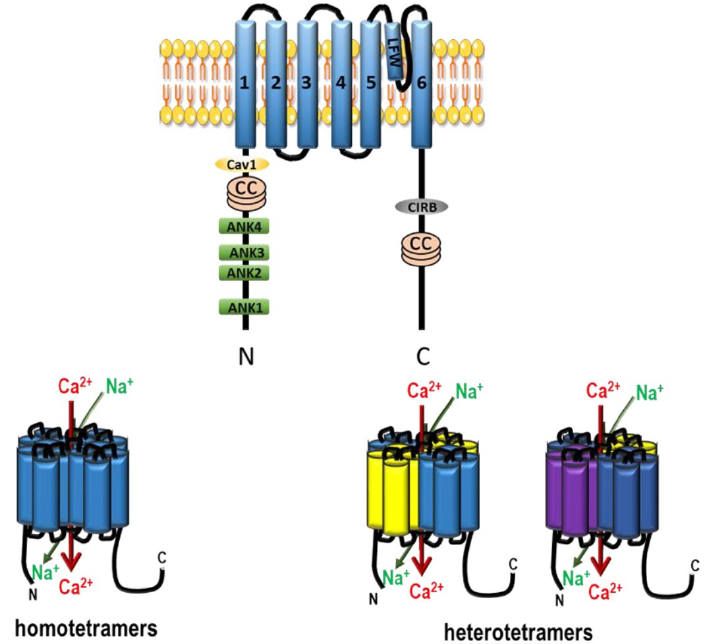
Figure 9. Architecture of TRPC channels. Each TRPC isoform is constituted of six transmembrane-spanning ion channels. Each TRPC subunit contains six transmembrane domains with the pore region (LFW, pore motif) between 5 and 6. Structural domains for channel assembly and protein interaction sites are located in the intracellular N and C termini. ANK1-4, ankyrin-like repeats; CC, coiled-coil domain; Ca v 1, caveolin-1 binding domain; CIRB, calmodulin–IP3R binding site. TRPC channels need homotetramerization or heterotetramerization to form a functional channel.